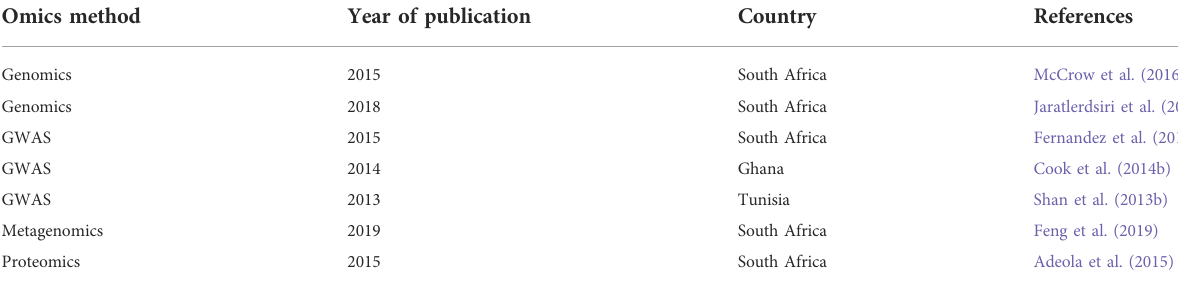
TABLE 1 List of African studies on prostate cancer